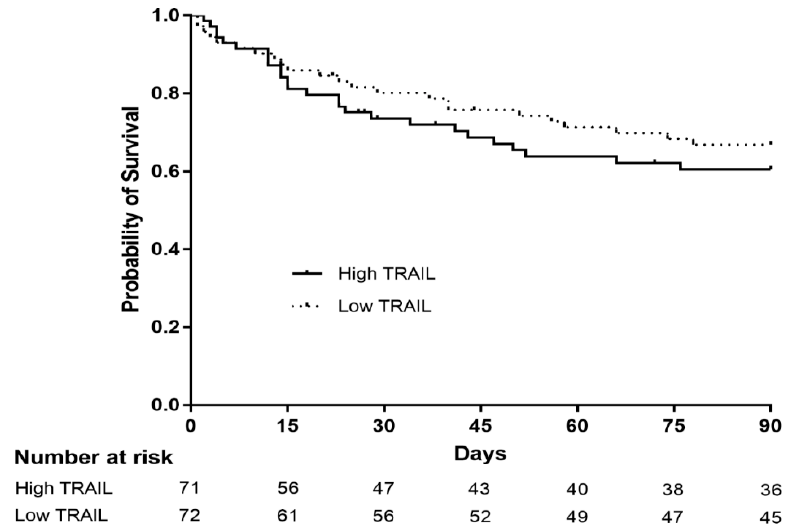
Figure 4. Kaplan–Meier survival analysis comparing patients with sepsis or septic shock with high and low plasma level of TRAIL (n = 143). The 30-day and 90-day survival estimates are 76.6% and 60.5%, respectively for patients with high TRAIL (solid line), while it is 80.2% and 66.9% for patients with low TRAIL (dotted line) ( p = 0.419, log-rank test). Table 2. Characteristics of patients with sepsis stratified according to the median level of plasma TRAIL (n = 143).